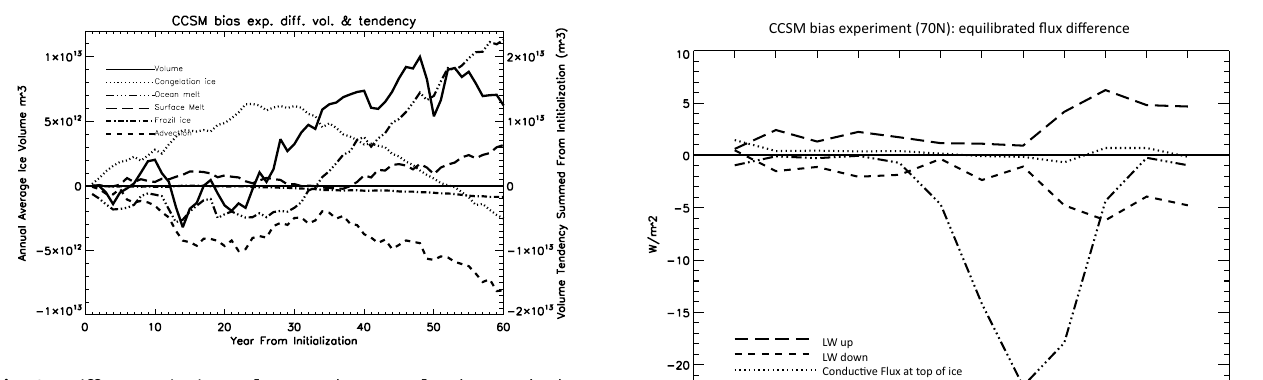
Fig. 9. Difference in ice volume and accumulated mass budget terms during CCSM bias experiment. Year since inception of the experiment is indicated on the x axis. Difference in annual aver- age ice volume (CCSM bias experiment less control) is represented by the solid line and left y axis. Other lines and the right x axis indicate cumulative difference in budget terms (CCSM bias exper- iment less control). A positive value indicates more ice is formed by a process or less melted in the bias experiment than in con- trol. Includes basal (congelation) ice growth, open water (frazil) ice growth, basal/lateral (Ocean) melt, surface melt, and loss to trans- port out of the Arctic (advection).